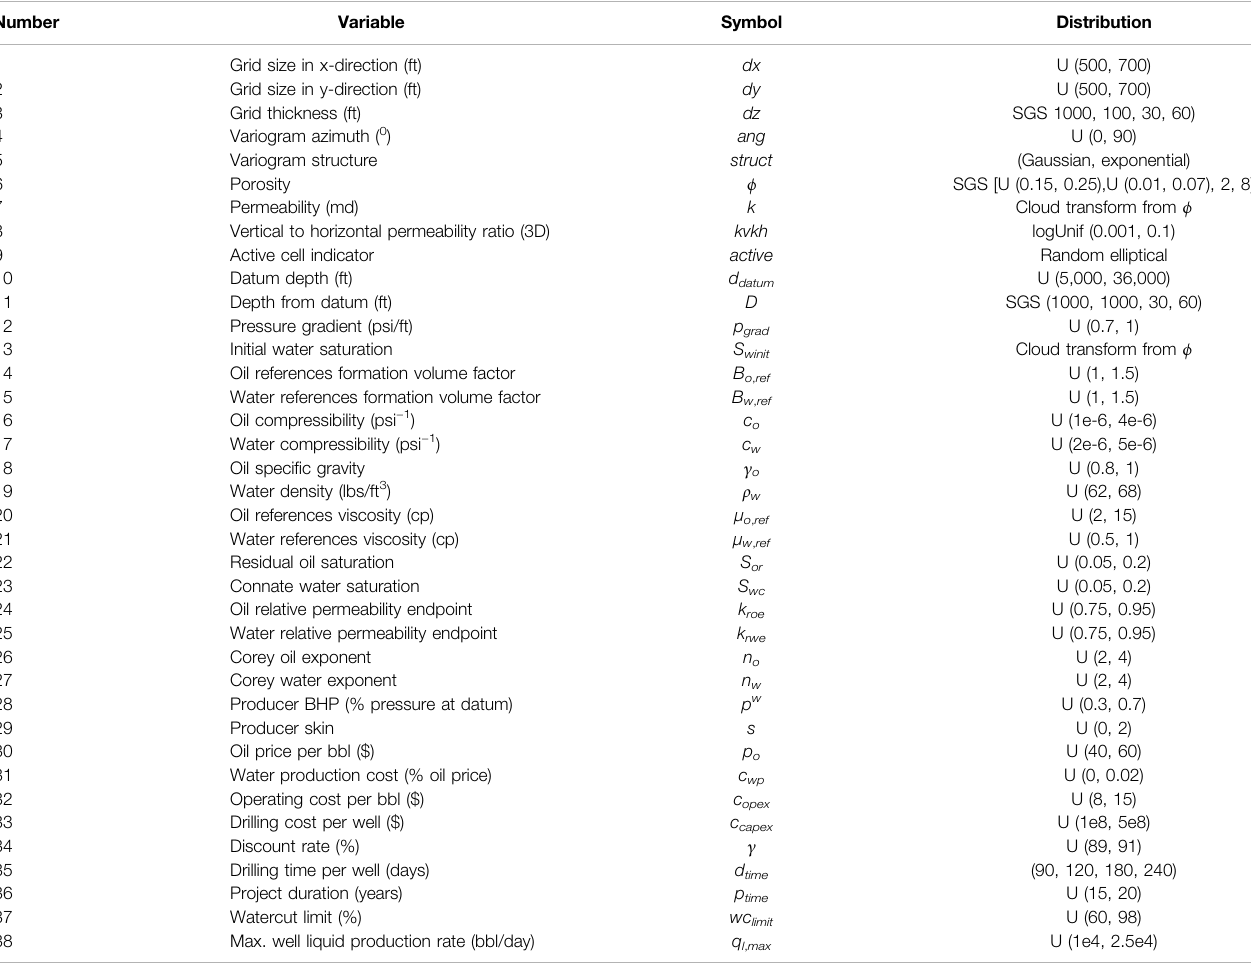
TABLE 1 | Distributionofparametersfor2Dand3Doil-water system fi eld developmentoptimization. U ( a , b )denotesuniformdistributionovertherangeof( a , b ).{ a 1 , a 2 , ... , a n } indicate uniform probability distribution over the n discrete options.